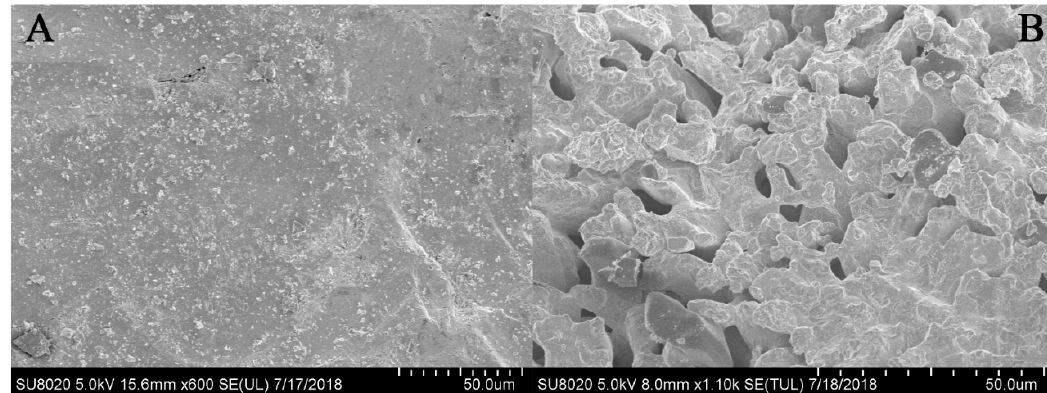
Figure 3. ( A ) SEM image of natural pyrite and ( B ) SEM image of modified pyrite.